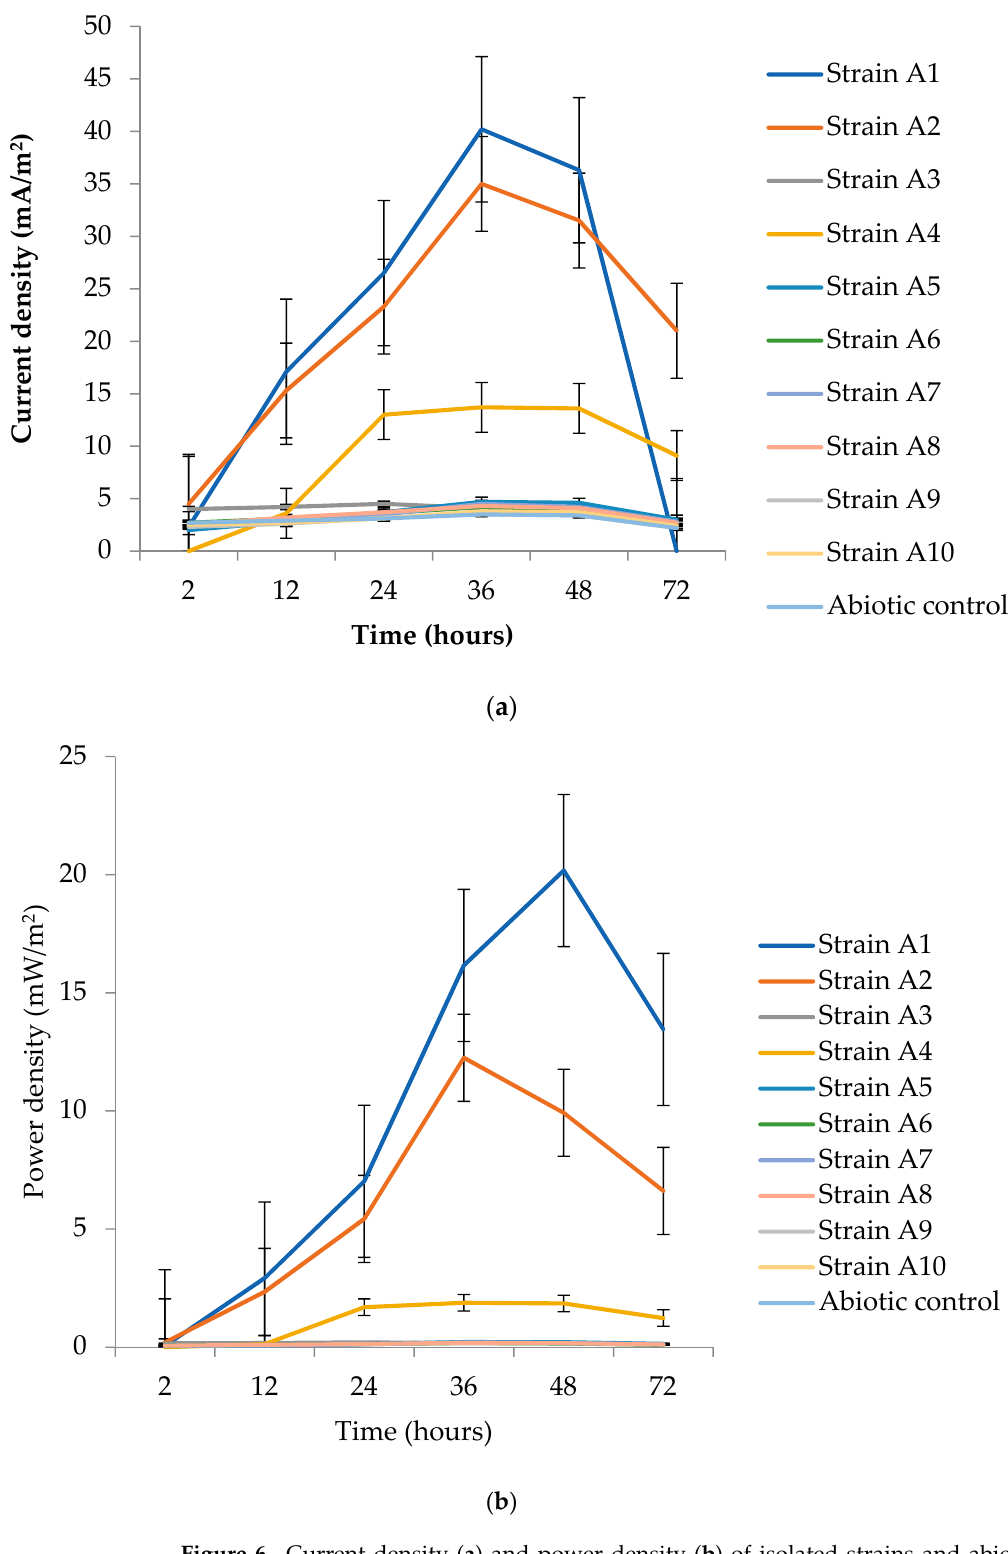
Figure 6. Current density ( a ) and power density ( b ) of isolated strains and abiotic control in a double-chambered MFC over 72 h.